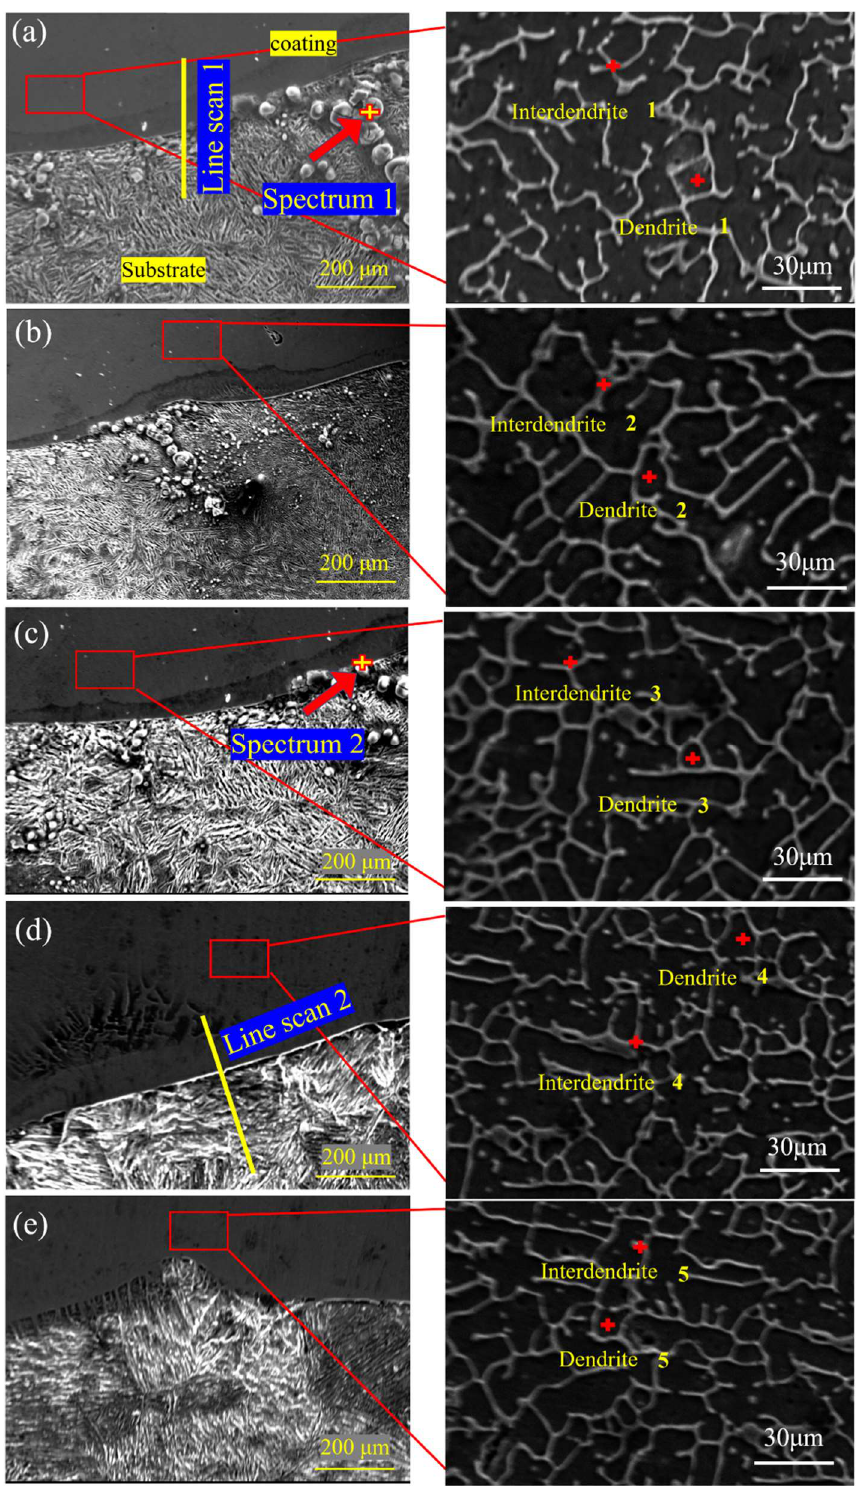
Figure 4. SEM diagram of the microstructure of the CoCrFeMnNiTi x high—entropy alloy cladding section: ( a ) Ti 0 , ( b ) Ti 0.25 , ( c ) Ti 0.5 , ( d ) Ti 0.75 , and ( e ) Ti 1 .